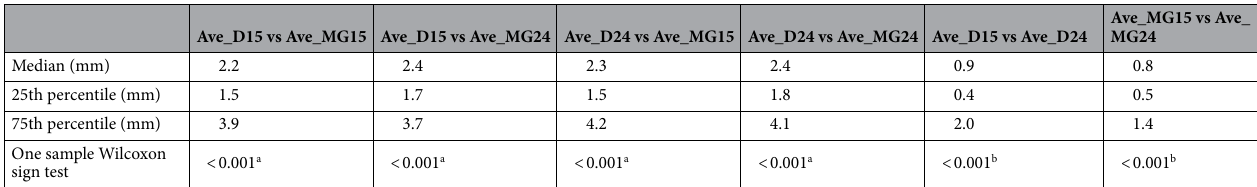
Table 3. Topographic surface analysis of three average faces generated by Di3DView with 15 (Ave_D15) or 24 landmarks (Ave_D24), and MorphAnalyser with 15 landmarks (Ave_MG15) and 24 landmarks (Ave_MG24)